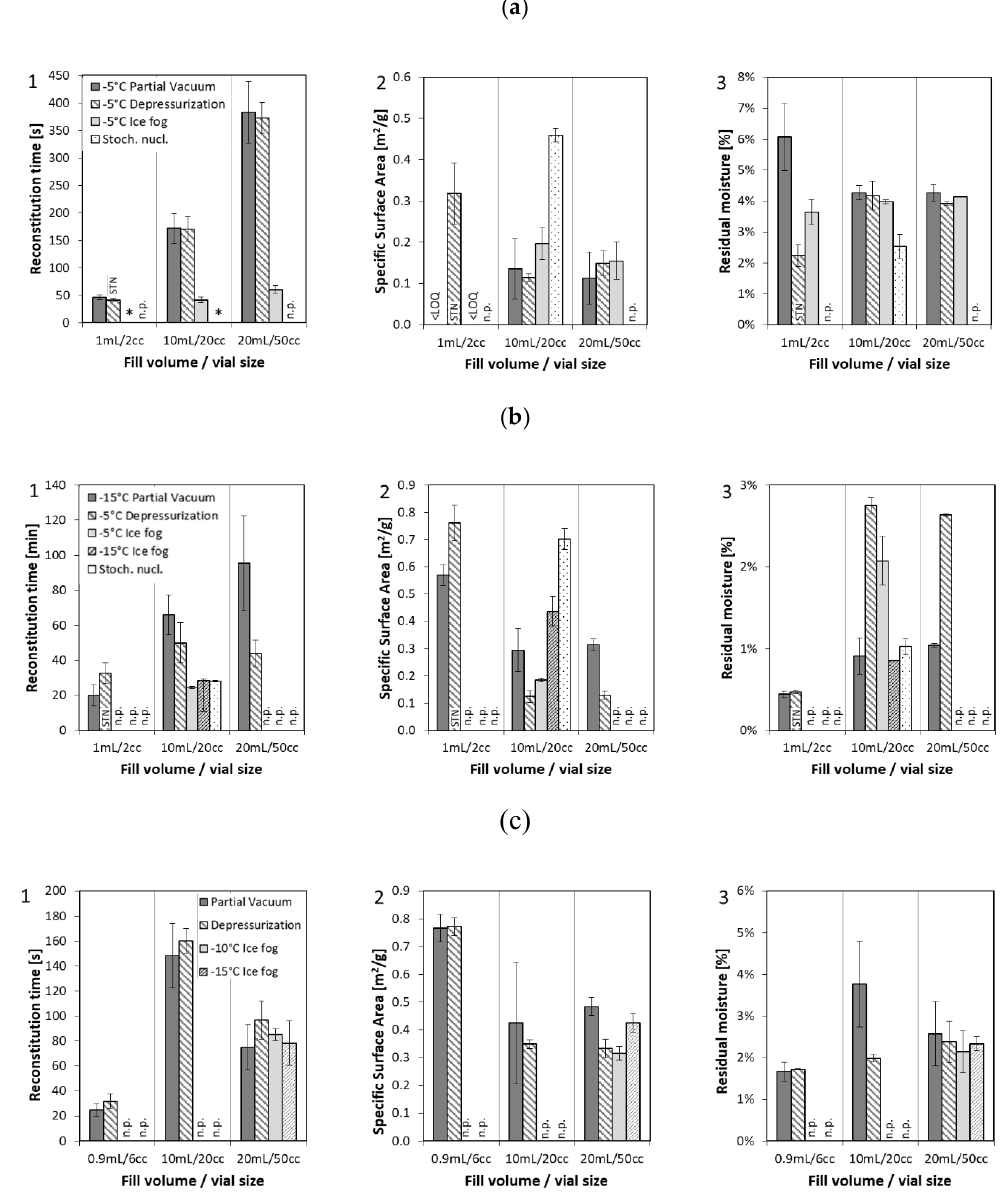
Figure 1. Solid state properties: (1) specific surface area, (2) residual moisture, and (3) reconstitution time of formulation 1–3 ( a ) mAb1 at 10 mg/mL, ( b ) mAb1 at 100 mg/mL, ( c ) enzyme at 2.5 mg/mL, lyophilized in different formats with three different nucleation techniques compared to stochastically nucleated samples. Nucleation temperatures are indicated in the legend of the graphs. * Immediate dissolution, n.p. = not performed, LOQ = limit of quantification, STN = stochastically nucleated. Cake appearance by visual inspection matched trends of SSA and residual moisture, and similar cake appearance was obtained between the samples from the three technologies as shown in Table 3.